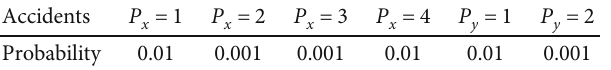
Table 7: Probabilities of primary gas explosion and secondary fi re and dust explosion accidents.